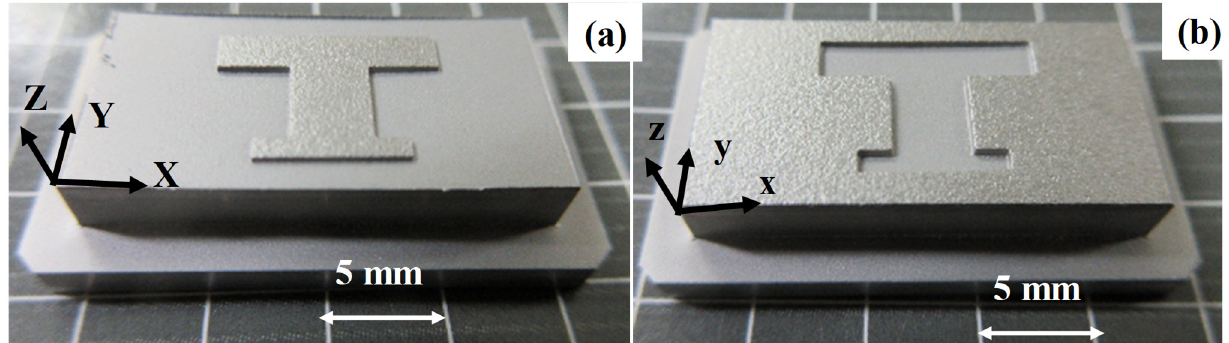
Figure 8. Optical microscopy image on the AISI316L substrates after sand-blasting for 600 s. ( a ) A nitrided AISI316L punch with its T-shaped head, and ( b ) a nitrided AISI316L core-die with its T-shaped cavity.